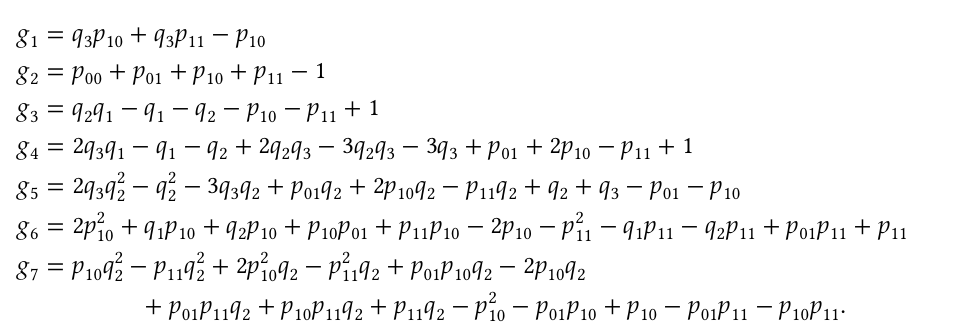
Figure 8: (a) u = uu and u = u ⊕ u ⊕ u . (b) | 4 (u The Groebner basis for the